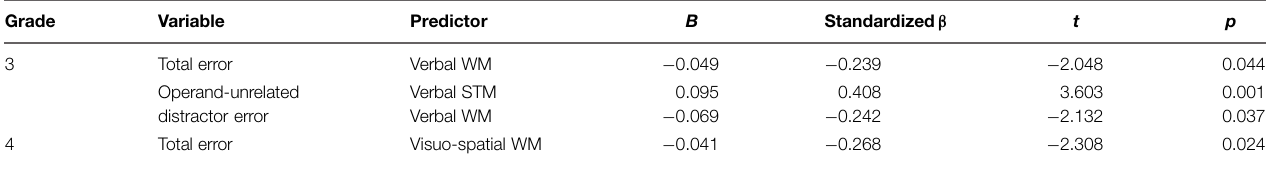
TABLE 3 | Results for significant predictors entered in the stepwise multiple regression